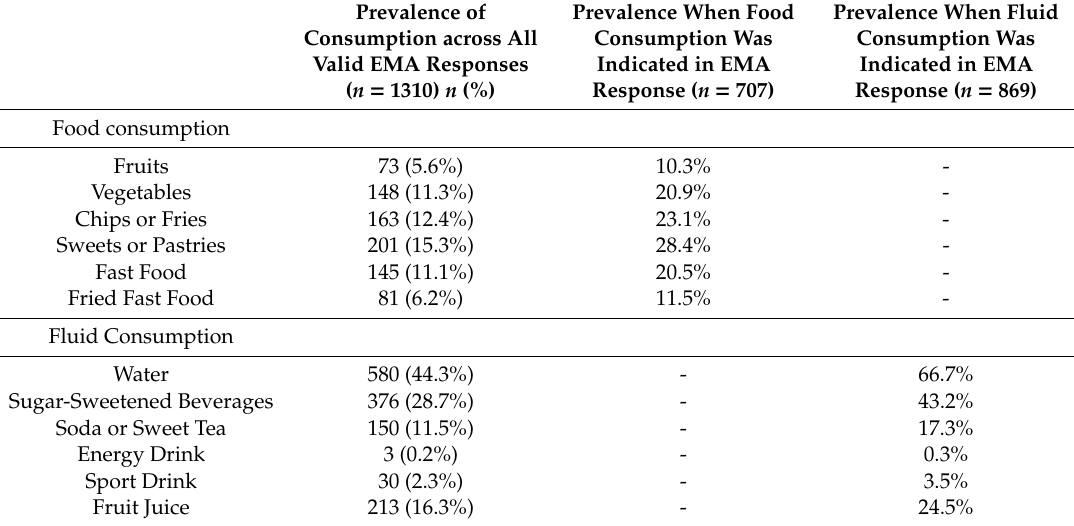
Table 1. Prevalence of food and fluid consumption across ecological momentary assessment (EMA)